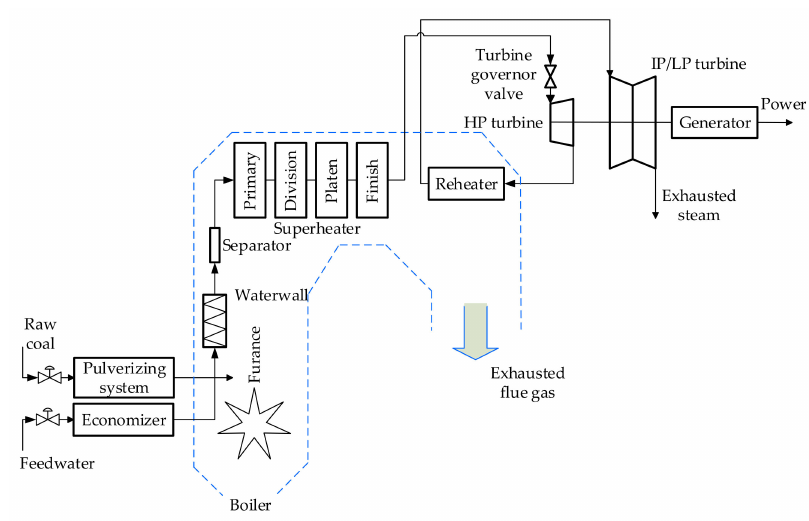
Figure 1. The layout of the 1000 MW boiler-turbine unit.